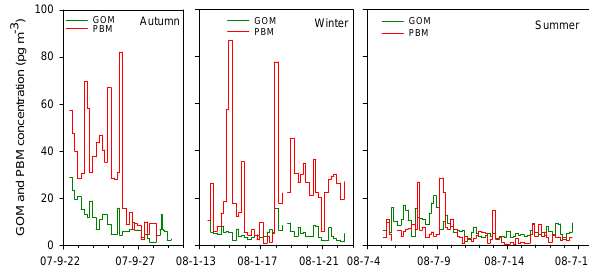
Fig. 3. Time series of PBM and GOM concentrations during the 4 selected sampling